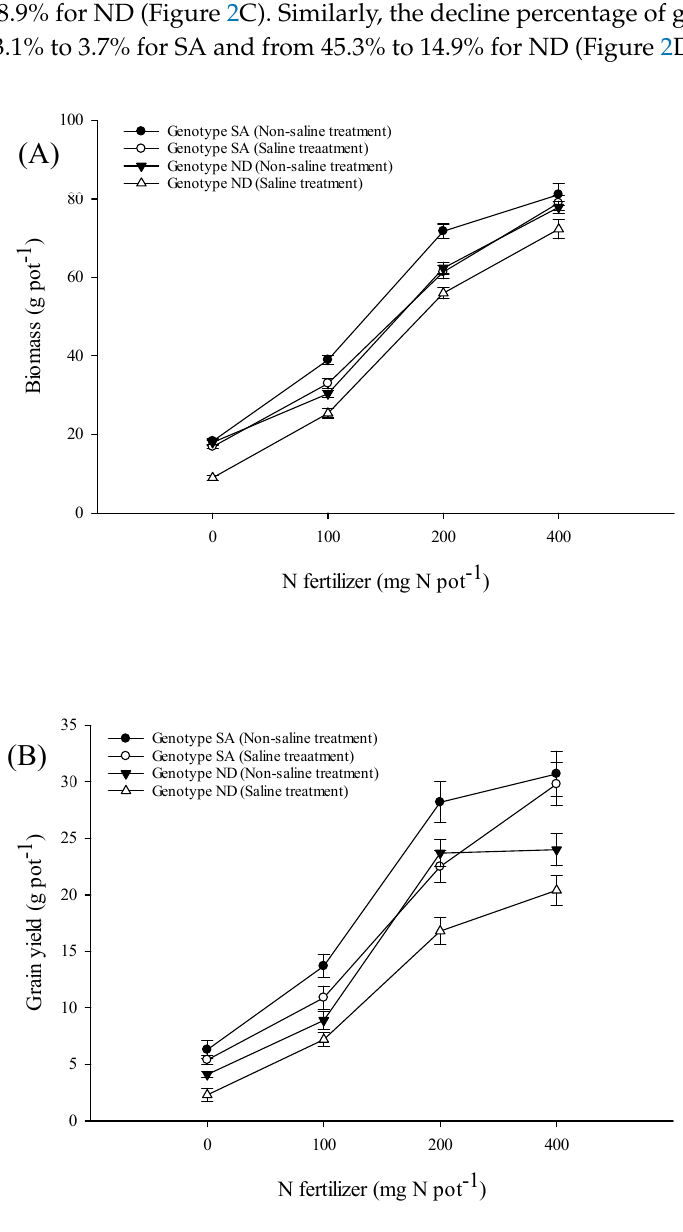
Figure 3. Effects of salinity and nitrogen rates on seed yield ( A ) and dry biomass ( B ) under non-saline and saline treatments.